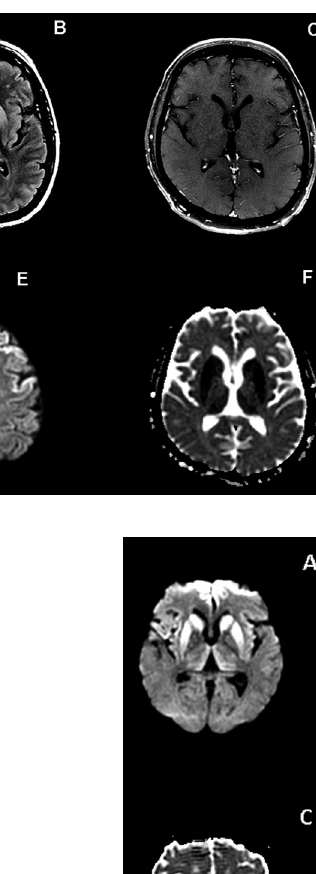
Figure 2. Case 1. Case 2: Axial DWI (A and B) shows hyper- intensity in basal ganglia, thalami, insular and frontal cor- tex, with corresponding restricted diffusion in ADC maps (C and D). There is also high signal involving these structures on axial FLAIR images (E and F). The DWI sequence is more sensitive for depicting MRI changes related to